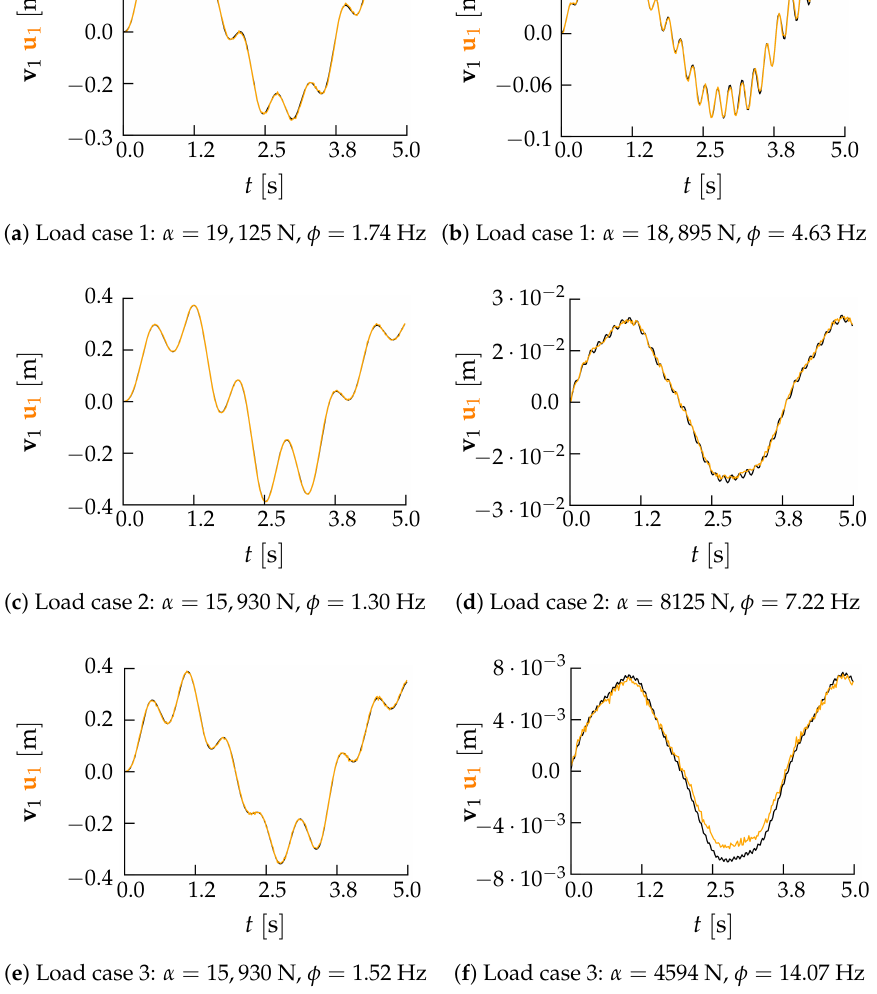
Figure 23. Pirelli Tower. Comparison between input (black lines) and reconstructed (orange lines) time histories of the 20-th floor displacement for six cases belonging to the test set.